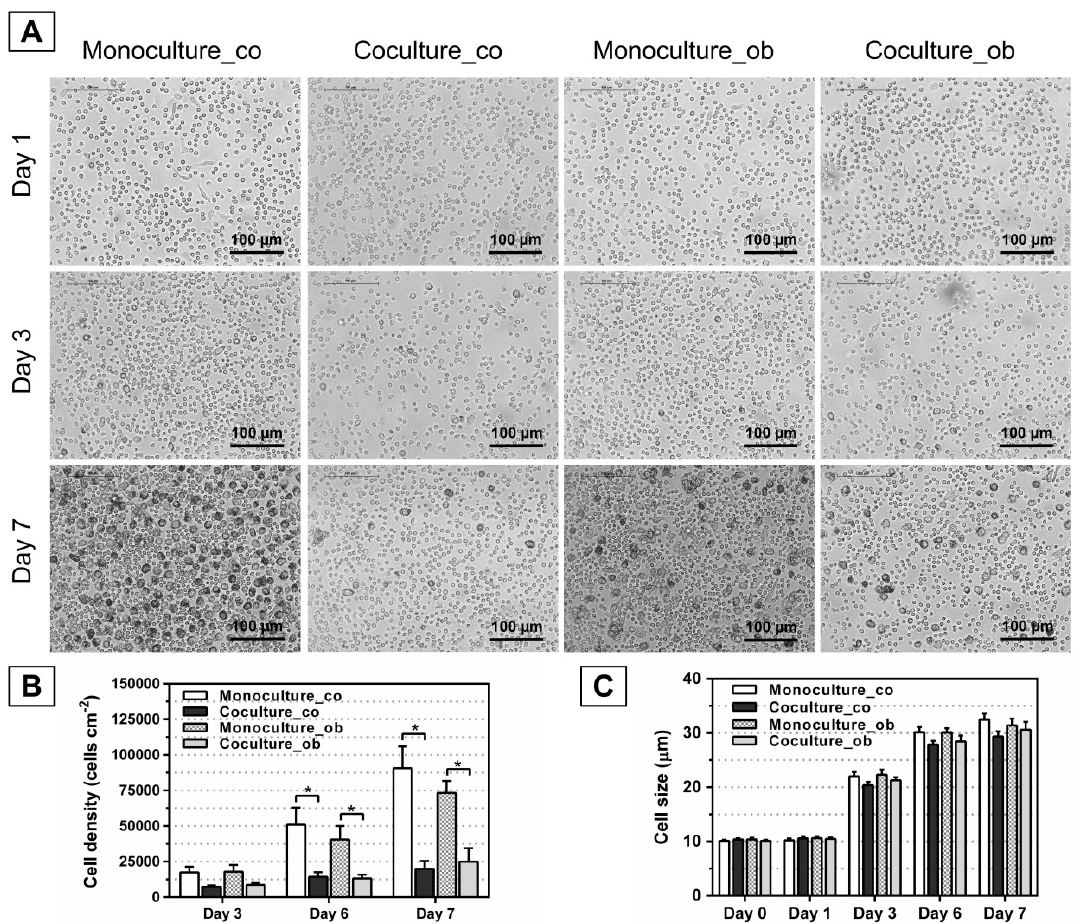
Figure 4. Morphology, cell numbers, and sizes of PBMCs during DC differentiation in monocultures or co-cultures with untreated (co) and osteogenically induced JPCs for 14 days (ob). Microscopic images of PBMCs during DC differentiation on day 1, day 3, and 7 are shown ( part A ); Resulting cell numbers (cells/cm 2 , part B ) and determination of cell sizes ( µ m, part C ) in mono- and co-cultures were quantified using the ImageJ software. Results were averaged from 6 independent experiments. Scale bar, 100 µ m.